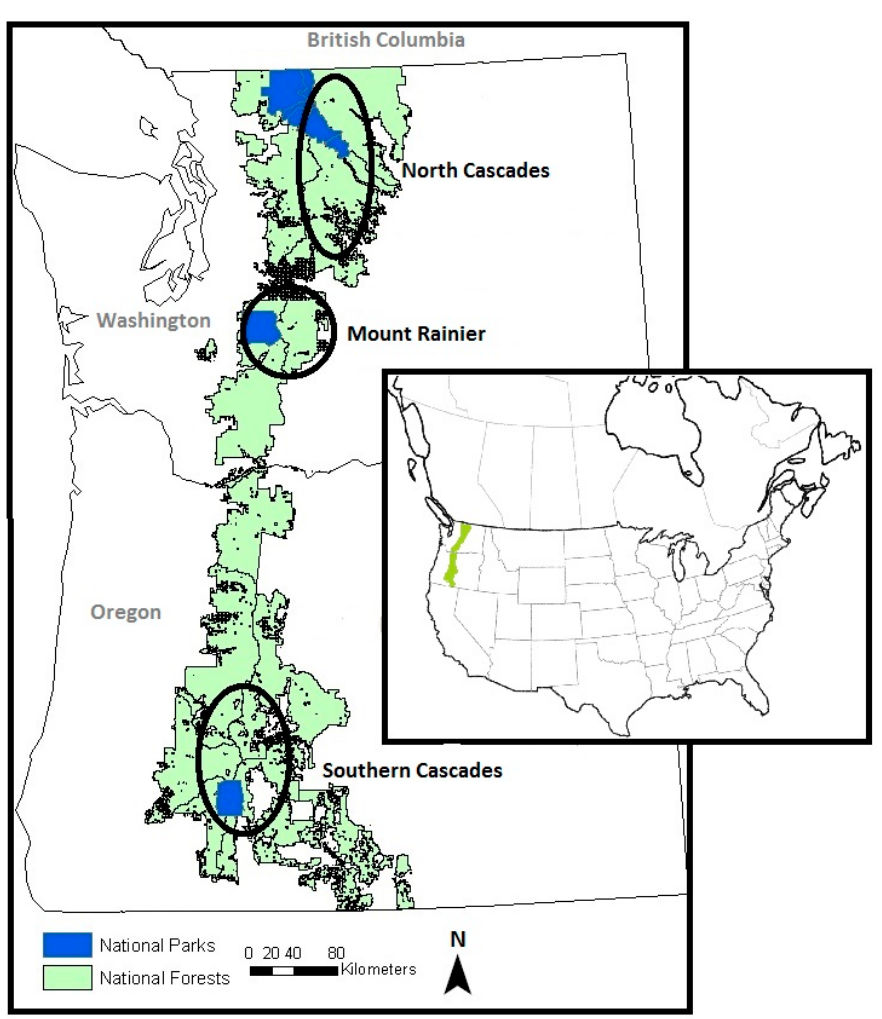
Figure 1. Location of three analysis areas where fire history plots were sampled in the Cascade Mountain Range.